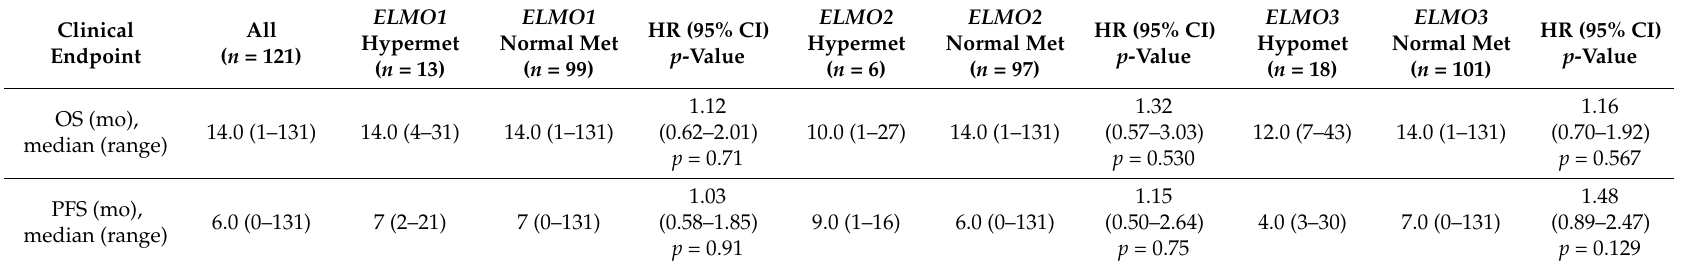
Table 2. Survival analyses according to DNA methylation status of the ELMO